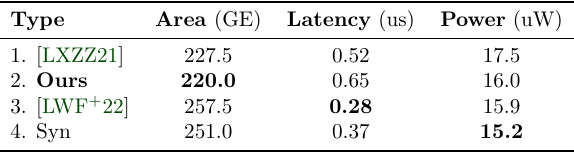
Table 4: The results of AES MixColumns in the UMC 55 nm library. “Ours” is from